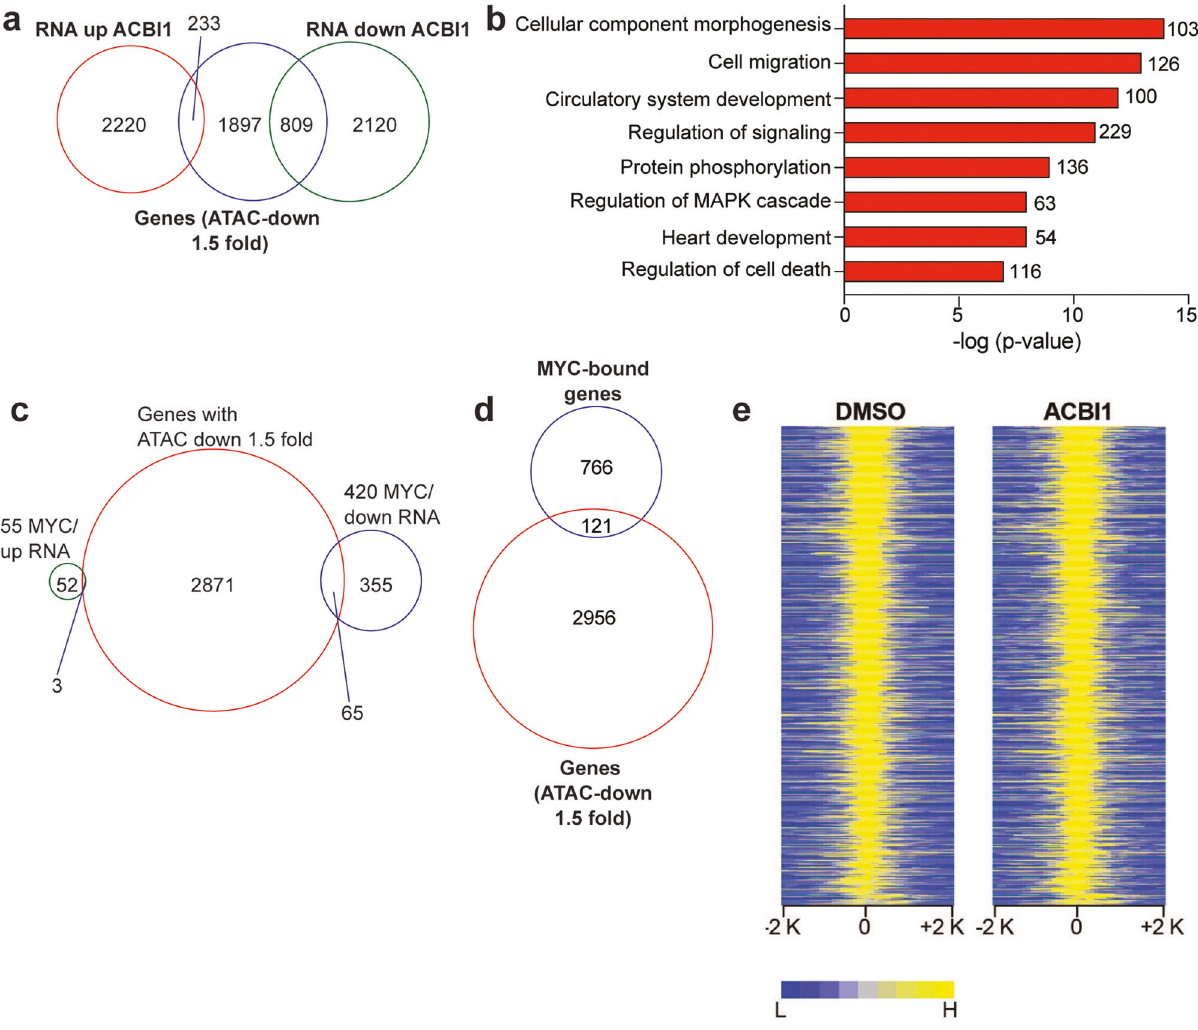
Fig. 6 SWI/SNF controls multiple oncogenic gene expression programs through TSS-proximal and TSS-distal mechanisms. a Venn diagram showing genes associated with decreased ATAC-seq peak intensity (fold change < − 1.5) and their overlap with genes that are increased or decreased in the RNA-seq analysis. b GO analysis of 809 genes in a that have decreased chromatin accessibility and a subsequent decrease in expression. c Venn diagram showing genes associated with decreased ATAC-seq peak intensity (fold change < − 1.5) compared to MYC target genes that had changed gene expression in Fig. 3a. d Venn diagram showing genes associated with decreased ATAC-seq peak intensity (fold change < − 1.5) compared to all MYC-bound genes in G401 cells. e Normalized ATAC-peak intensities for DMSO and ACBI1 samples are shown for all MYC-bound genes. ACBI1 peaks are ranked against those in DMSO